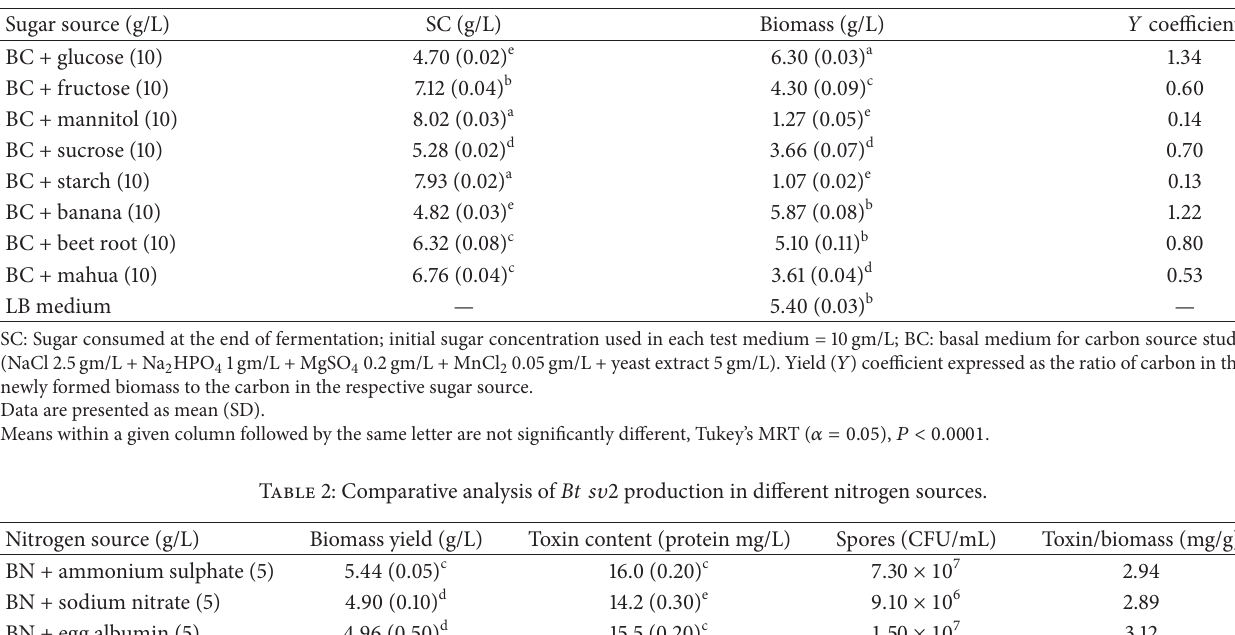
Table 1: Biomass production of Bt 𝑠𝑣2 in different carbon sources.